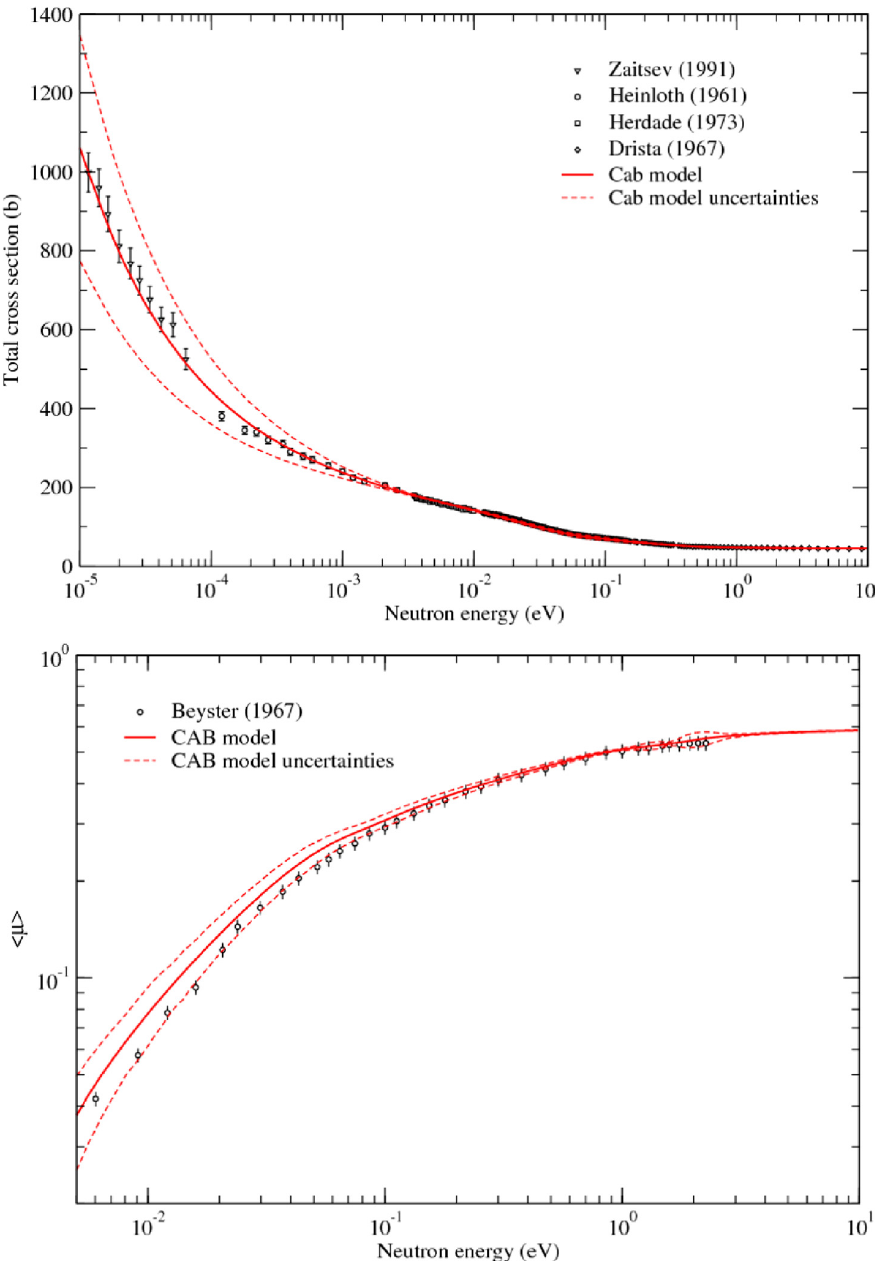
Fig. 8. Comparison of the theoretical scattering cross section (top plot) and of the average cosine m of the scattering angle (bottom plot) with the experimental data introduced in the CONRAD